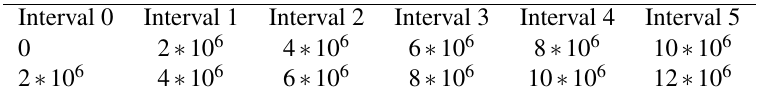
Table 3. Umbralization